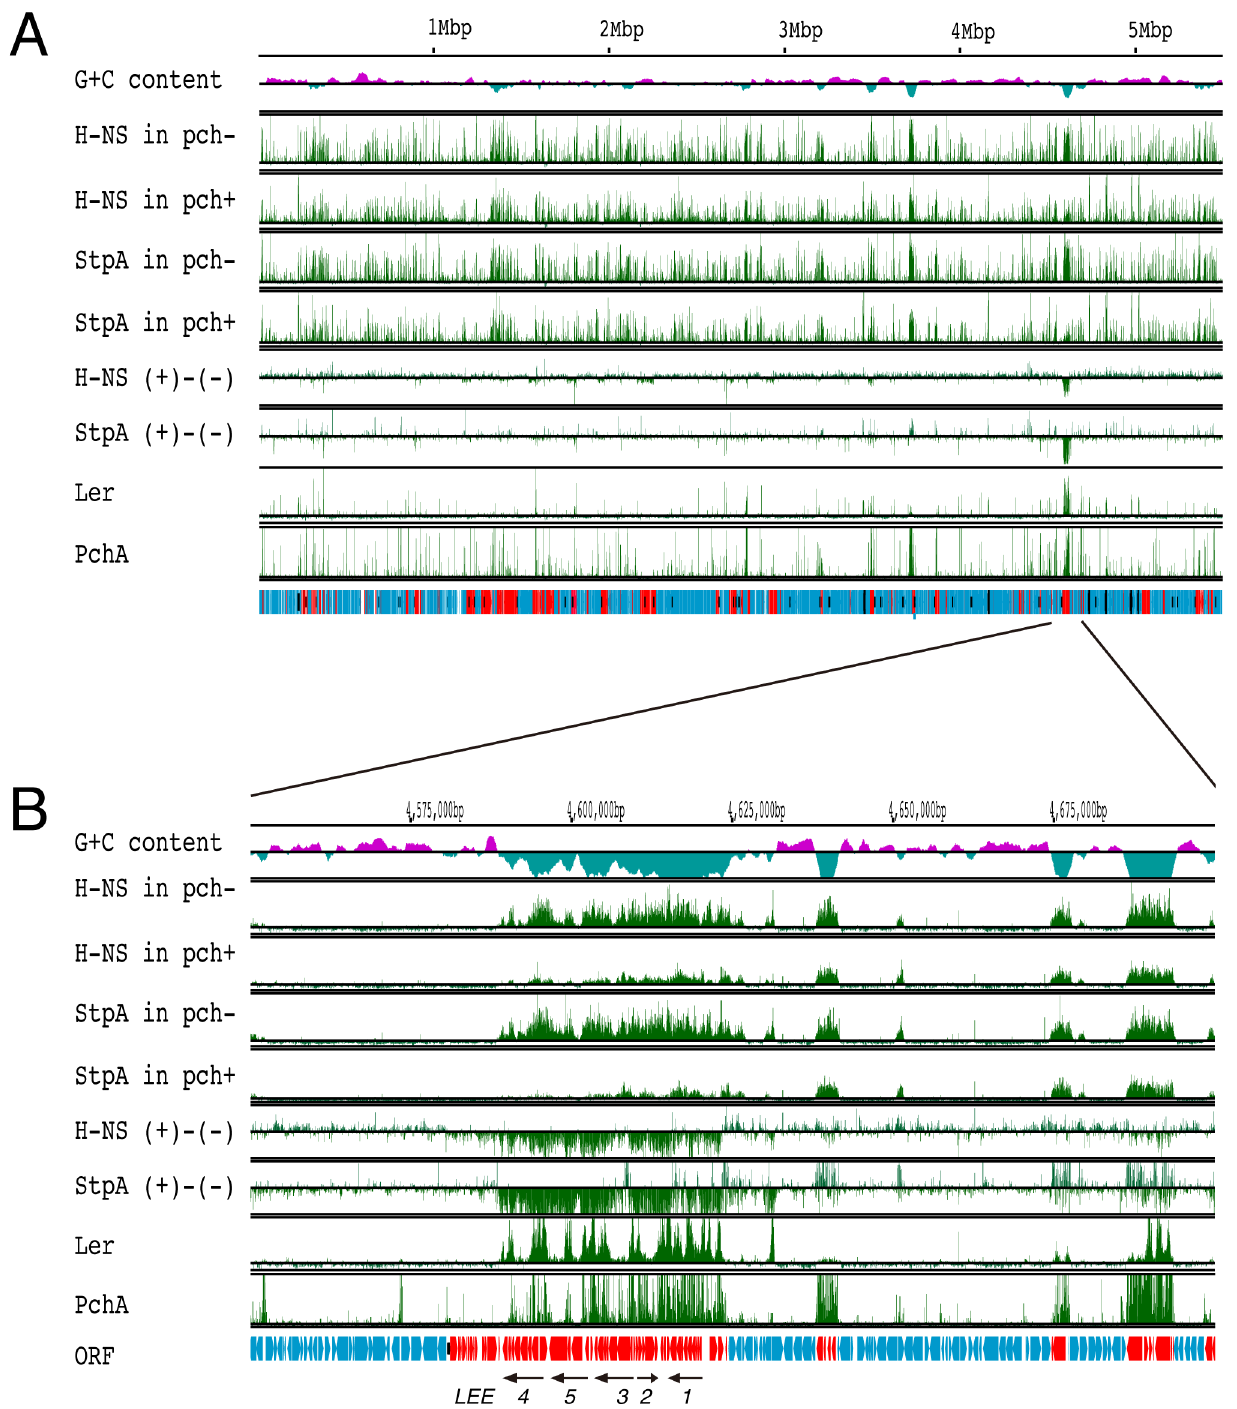
Fig 4. Effects of pch expression on H-NS and StpA bindings. A. Distribution of H-NS and StpA binding over the EHEC O157 Sakai chromosome. The top column shows G+C content. 2 nd and 3 rd graphs show H-NS binding in EHEC deficient in pch (pch-) and a pch -expressing strain (pch+). The 4 th and 5 th graphs show StpA binding in EHEC deficient in pch (pch-) and a pch -expressing strain (pch+). The 6 th and 7 th columns show differences in H-NS and StpA binding between pch (-) and pch (+) strains. The 8 th and 9 th columns show Ler and Pch binding from previous data [14], respectively. The bottom column shows ORFs in the E . coli K12-common chromosome (blue) and ORFs in the LEE and in the other laterally transferred elements (red). B. Distribution of H-NS binding in the LEE and surrounding region of EHEC O157 Sakai. Arrows at the bottom show the positions of the LEE operons. The resolution was estimated around 50bp from density of microarray and fragmentation of